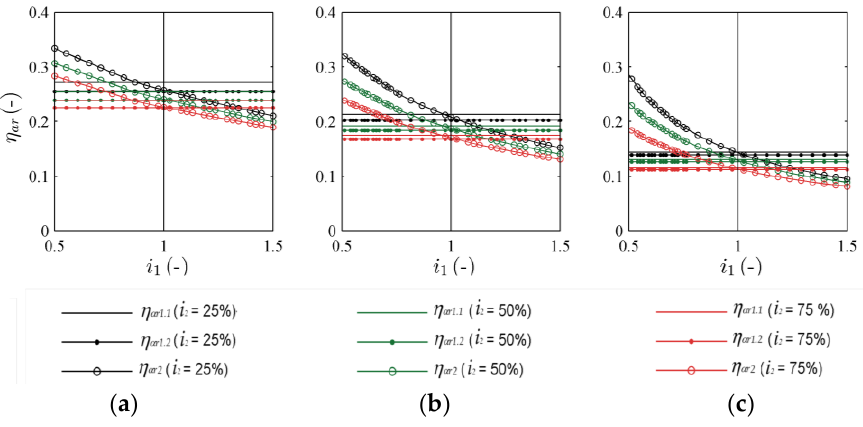
Figure 13. Trend of efficiency indices reported by the authors of [34,35] for ∆ H ind = 25 m ( a ); ∆ H ∆ H ind = 50 m ( b ); and ind = 100 m ( c